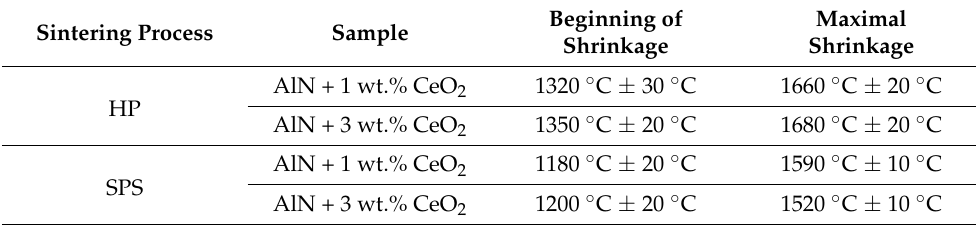
Table 2. Distinctives temperatures of ceramics obtained by both HP and SPS.